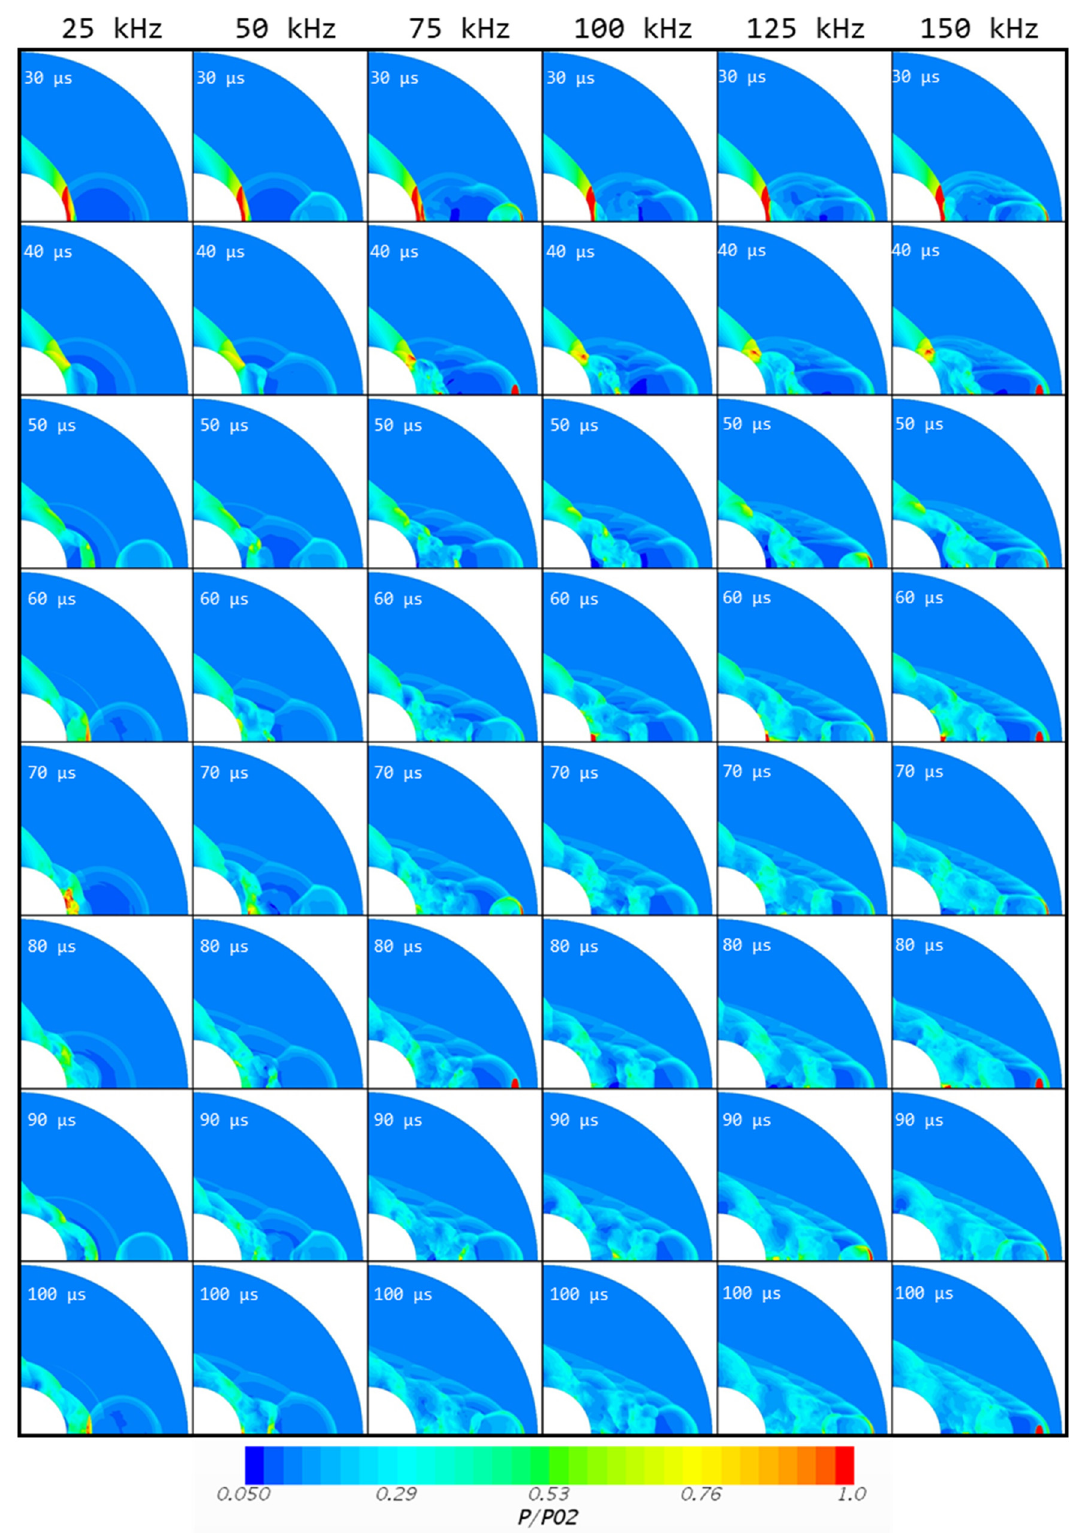
Figure 8. Normalized pressure contour vs. time for various deposition frequencies.